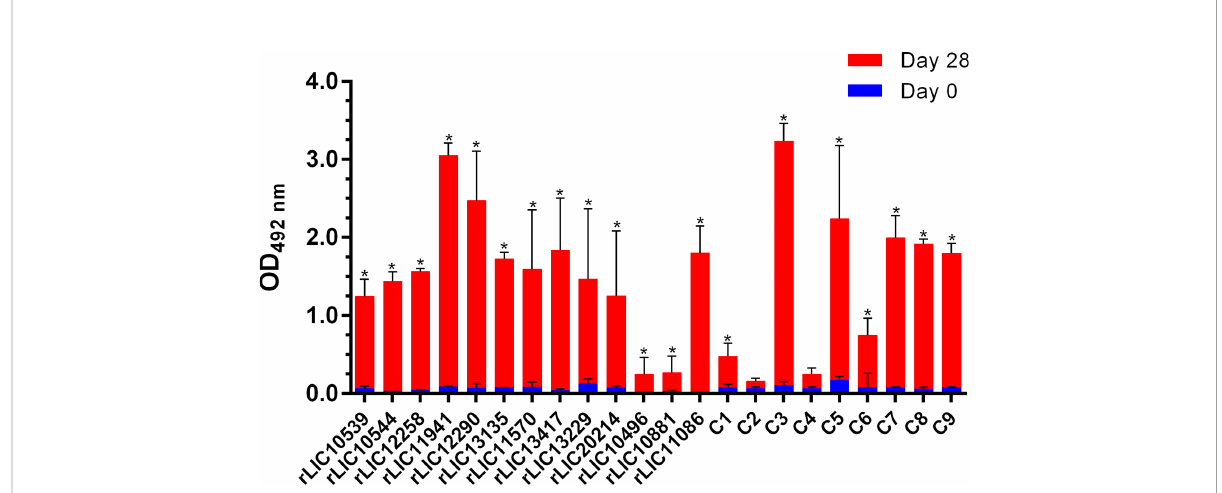
FIGURE 4 Speci fi c humoral immune response (IgG) in vaccinated hamsters. ELISAs were carried out to determine the antibody levels in hamsters vaccinated with the recombinant proteins or the PBS control (Table 2). Pre-immune and pre-challenge serum samples were characterized using an anti-hamster IgG secondary antibody. The serum samples were diluted at 1:100 except for rLIC10881 and C6 (1:50), rLIC11570, rLIC13229, rLIC13417*, rLIC20214 (1:200) and LIC10496 and LIC11086 (1:400). The results represent the mean optical density (OD 492 ) ± standard deviation (bars) calculated from individual serum samples assayed in triplicate. Signi fi cance differences ( P < 0.05) were determined by one-way ANOVA (Tukey multiple comparison). *, indicates a signi fi cant difference between pre-immune sera and day 28 post